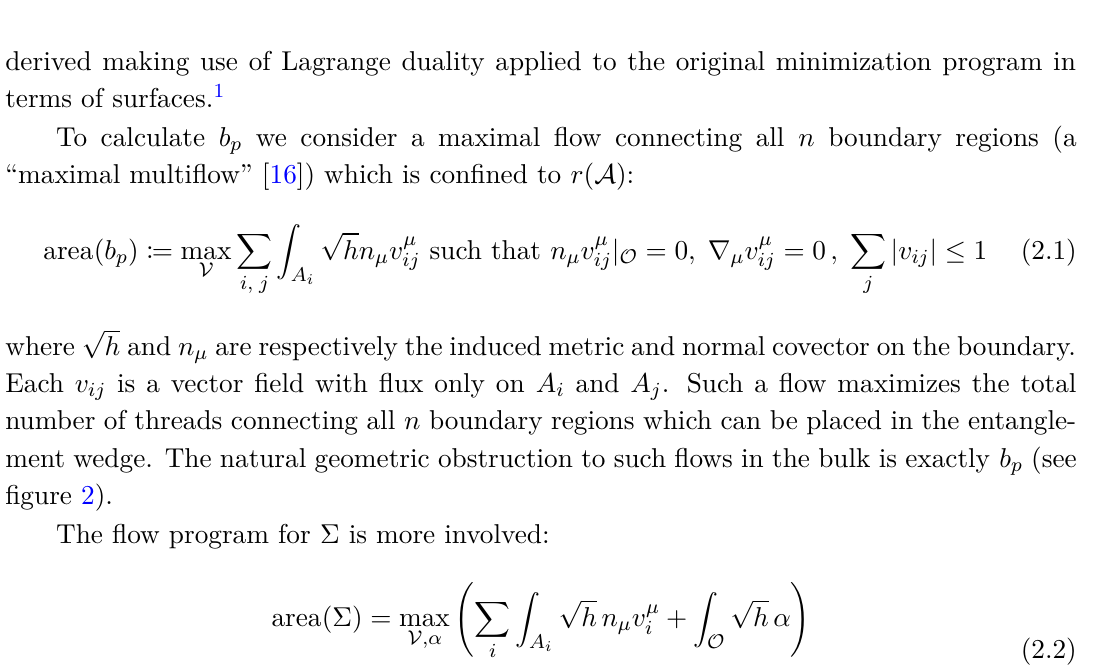
Figure 2 . The sum of the area of the bipartite homology region cross sections for multiple regions is given by the flux of a maximal multiflow confined to r ( A )